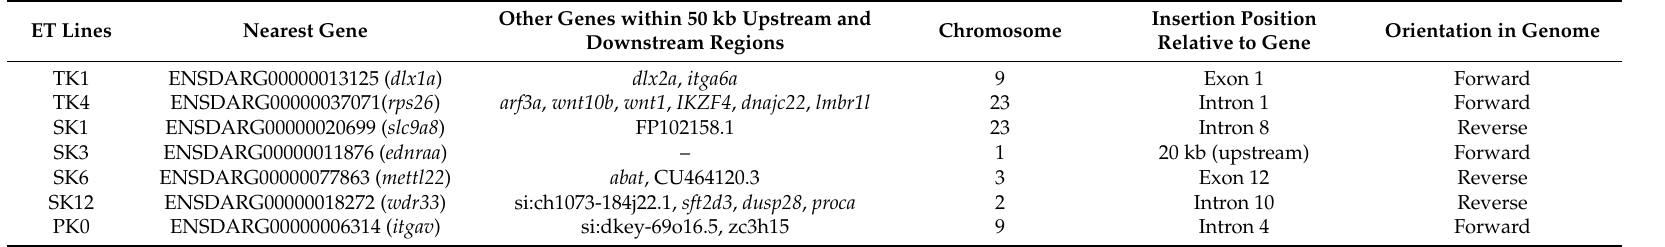
Table 1. Insertion sites in seven ET